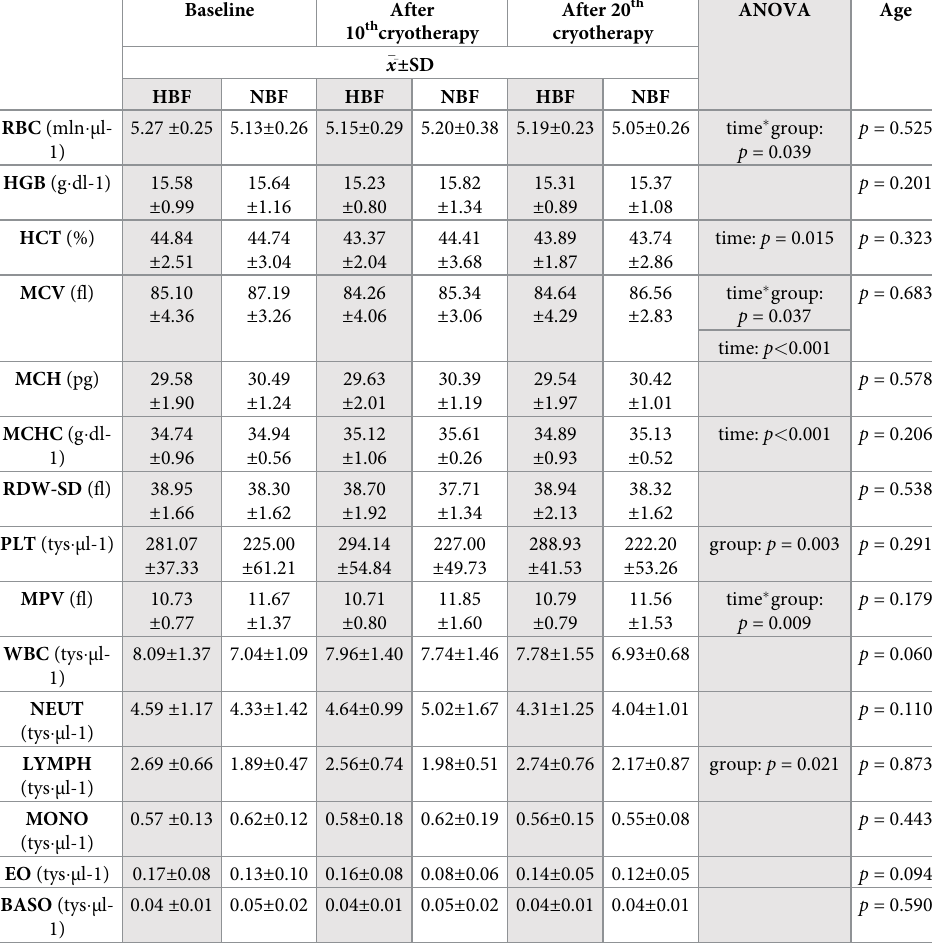
RBC- red blood cells; HGB—hemoglobin; HCT- hematocrit; MCV—mean corpuscular volume; MCH—mean corpuscular hemoglobin; MCHC—mean corpuscular hemoglobin concentration; PLT—thrombocytes, RDW—SD— red blood cell distribution width; MPV—mean platelet volume, WBC—white blood cells; NEUT -neutrophiles, LYMPH—lymphocytes; MONO—monocytes; EO -eosinophiles, BASO–basophiles.